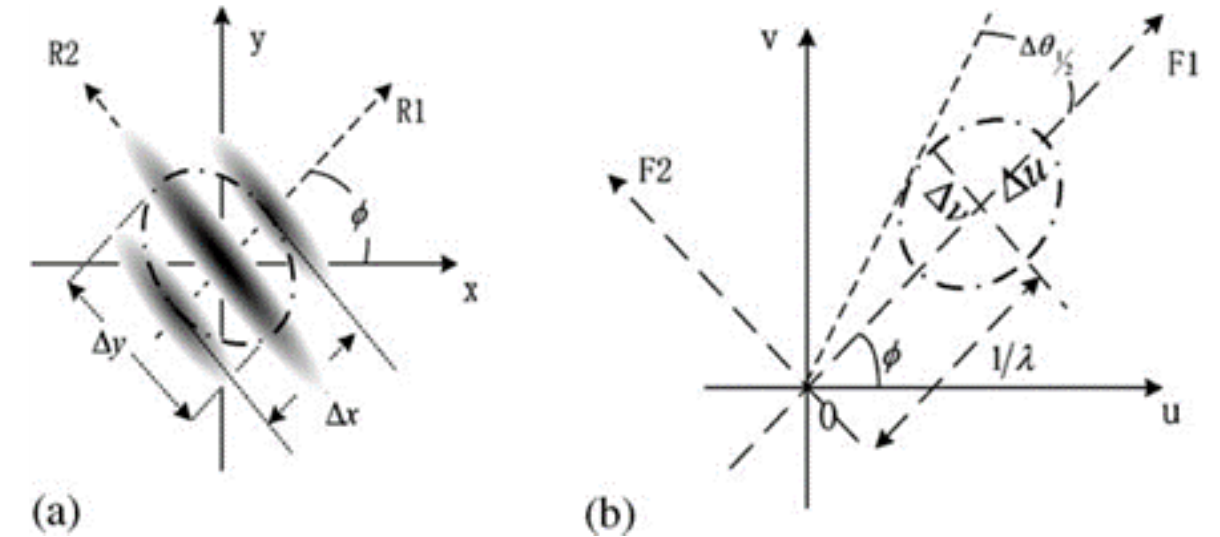
Figure 5. The proposed hybrid model steps. ( a ) spatial field viewpoint of a Gabor filter; ( b ) spatial frequency field.